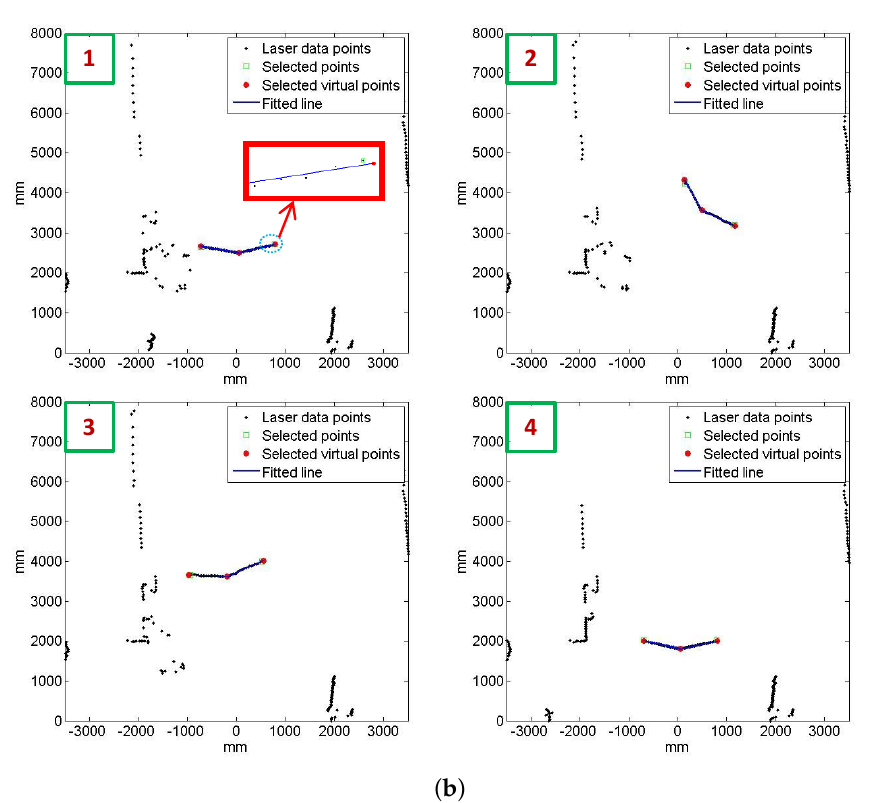
Figure 6. Four pairs of images and LiDAR scans are used as the ground truth. The calibration target was placed with two straight poses and two rotated poses. ( a ) Ground truth images. The blue line is the mid-line of the marked tape. The three red lines are line features extracted manually. The yellow points are the end points of each line features; ( b ) Ground truth LiDAR features. The green squares are the LiDAR points closest to both of the edges. The red dots are LiDAR features at each position. The red box shows a close-up image of the fitted line and the selected LiDAR point and the LiDAR feature of the right edge. The numbers on upper-left corner mean corresponding data between images and LiDAR data